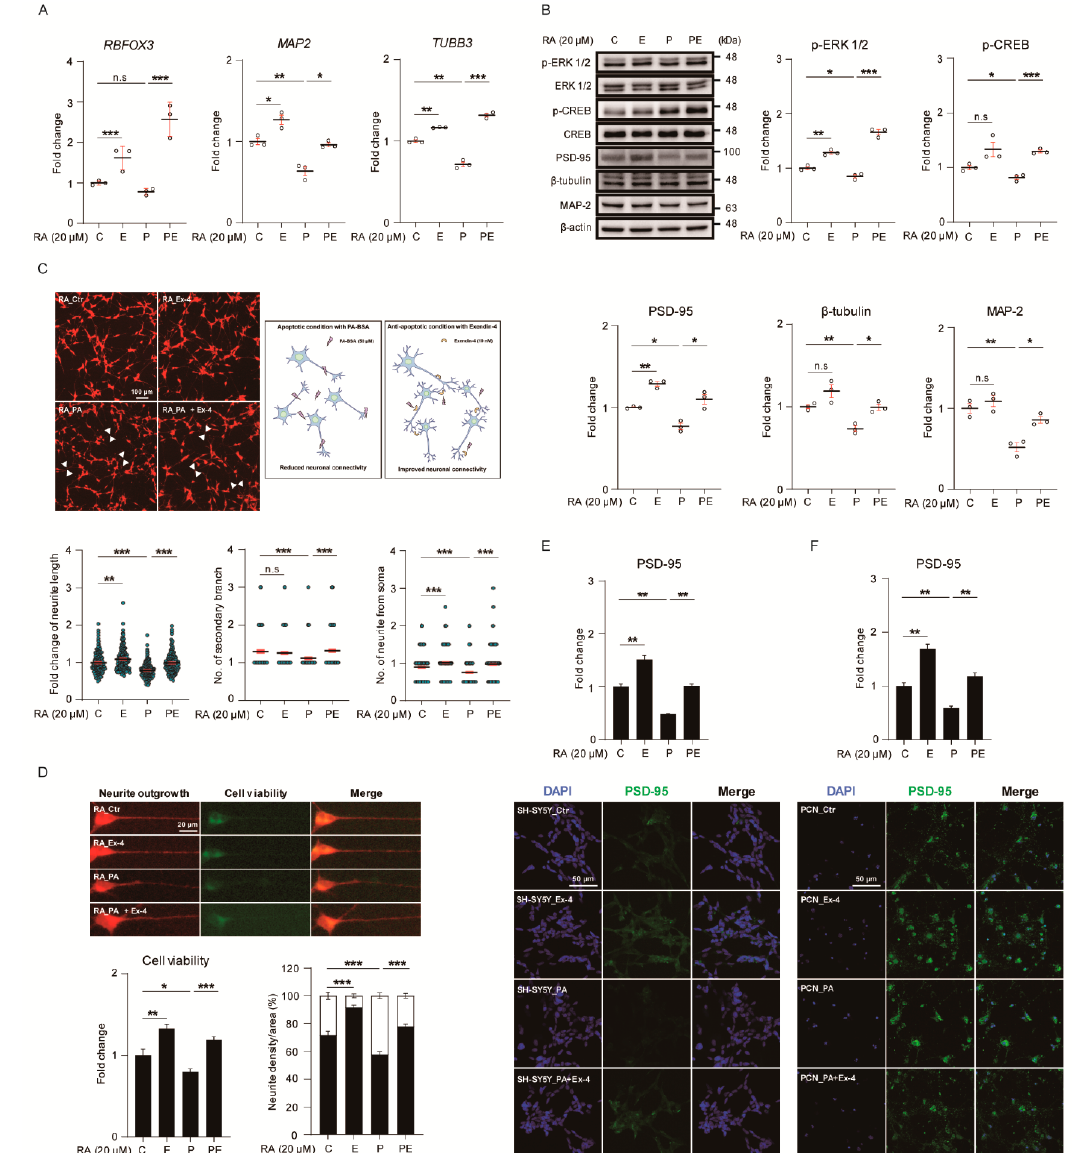
Figure 4. Exendin-4 improves the neural structure by promoting neural differentiation under palmitic acid-induced oxi- dative stress. ( A ) Comparison mRNA expression of gene-related with neural differentiation ( RBFOX3 , TUBB3 , and MAP2 ) in SH-SY5Y cells treated with vehicle (C or Ctr), Exendin-4 (E or Ex-4), palmitic acid (P or PA), and both palmitic acid and Exendin-4 (PE or PA+Ex-4). The mRNA level of each gene is normalized to GAPDH level. ( B ) Western blot of neural differentiation signaling was promoted by Ex-4 treatment in SH-SY5Y cells treated with reagents described in A. Each protein level is normalized to β -actin. The phosphorylation of pERK 1/2 and pCREB is normalized to ERK 1/2 and CREB total form, respectively. ( C ) Fluorescent images of RA-induced differentiated SH-SY5Y cells treated with reagents de- scribed in A. Scale bar: 100 μ m. Neurite complexity (neurite length, number of secondary branches, and neurite from soma) was analyzed from >150 cells per group. The white point indicates PA-induced damaged neurite site and recovered neurite of Ex-4 treated group. ( D ) Fluorescent images of cell viability (green) and neurite shrinkage (red) in RA-induced differentiated SH-SY5Y cells treated with reagents described in A. Scale bar: 10 μ m. ( E , F ) immunocytochemistry images of PSD-95 expression in SH-SY5Y cells and PCN neurons on day 21 in vitro (DIV21) treated with reagents described in A. Nuclei were counterstained with DAPI (blue) and insulin receptor stained with PSD-95 (green), >100 ( E ) and >50 ( F ) cells per group were analyzed. Scale bar: 50 μ m. Data information: SH-SY5Y cells were treated with 10 nM of Exendin-4 and 50 μ M of palmitic acid per group according to the treatment plan (Figure S1B,D) In ( A – F ), error bars represent S.E.M. from three independent experiments. n.s p > 0.05, * p < 0.05, ** p < 0.01, *** p < 0.001 (unpaired two-tail t-tests with Welch’s correction).